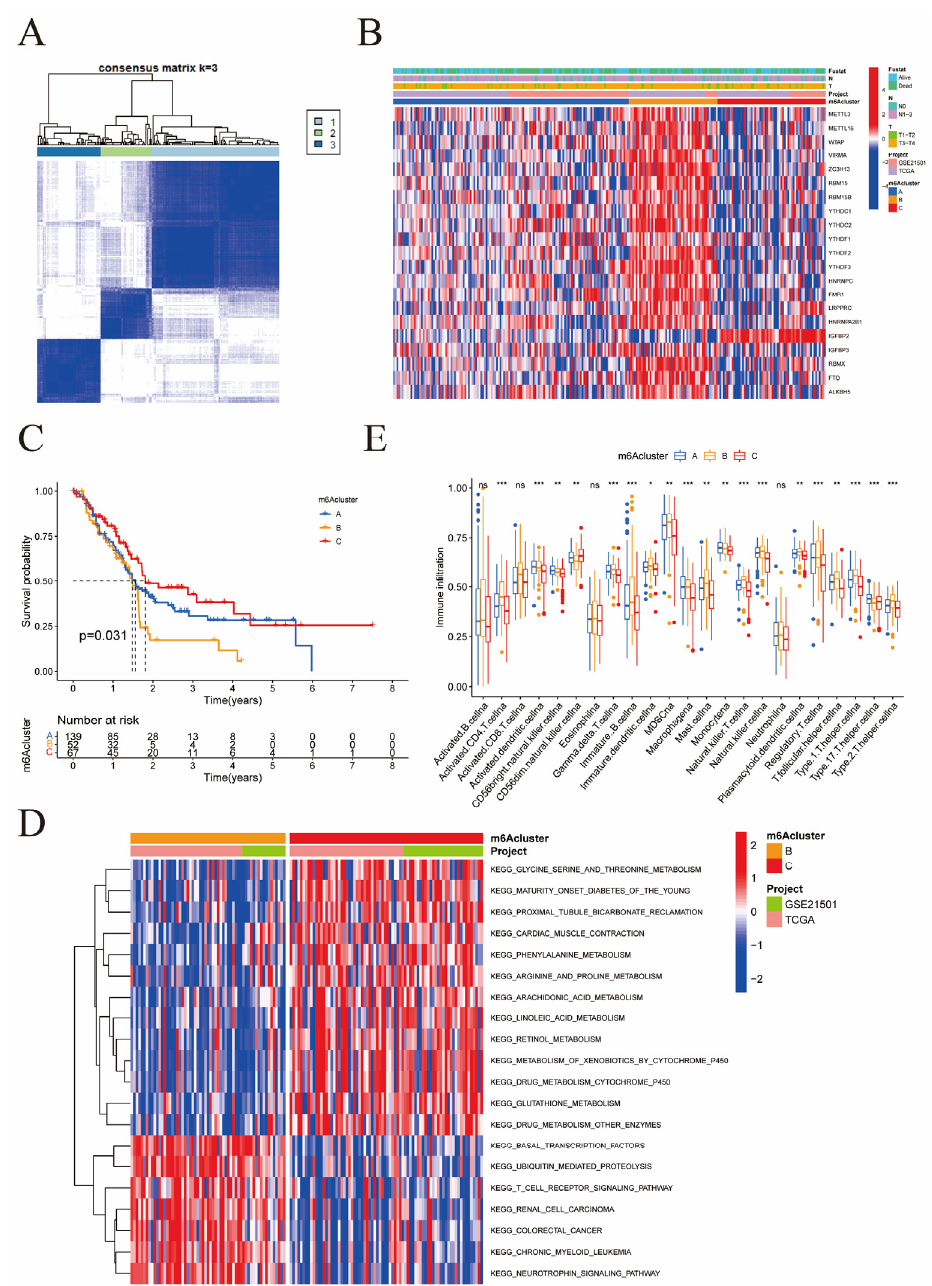
Figure 3. ( A ) Different m6A typings; ( B ) Heat map results made by correlating patients’ clinicopathological features and gene expression; ( C ) Survival analysis of different m6A clusters; ( D ) Biological life information pathways between m6A typing C and B; ( E ) ssGSEA analysis (* p < 0.05; ** p < 0.01; *** p < 0.001).